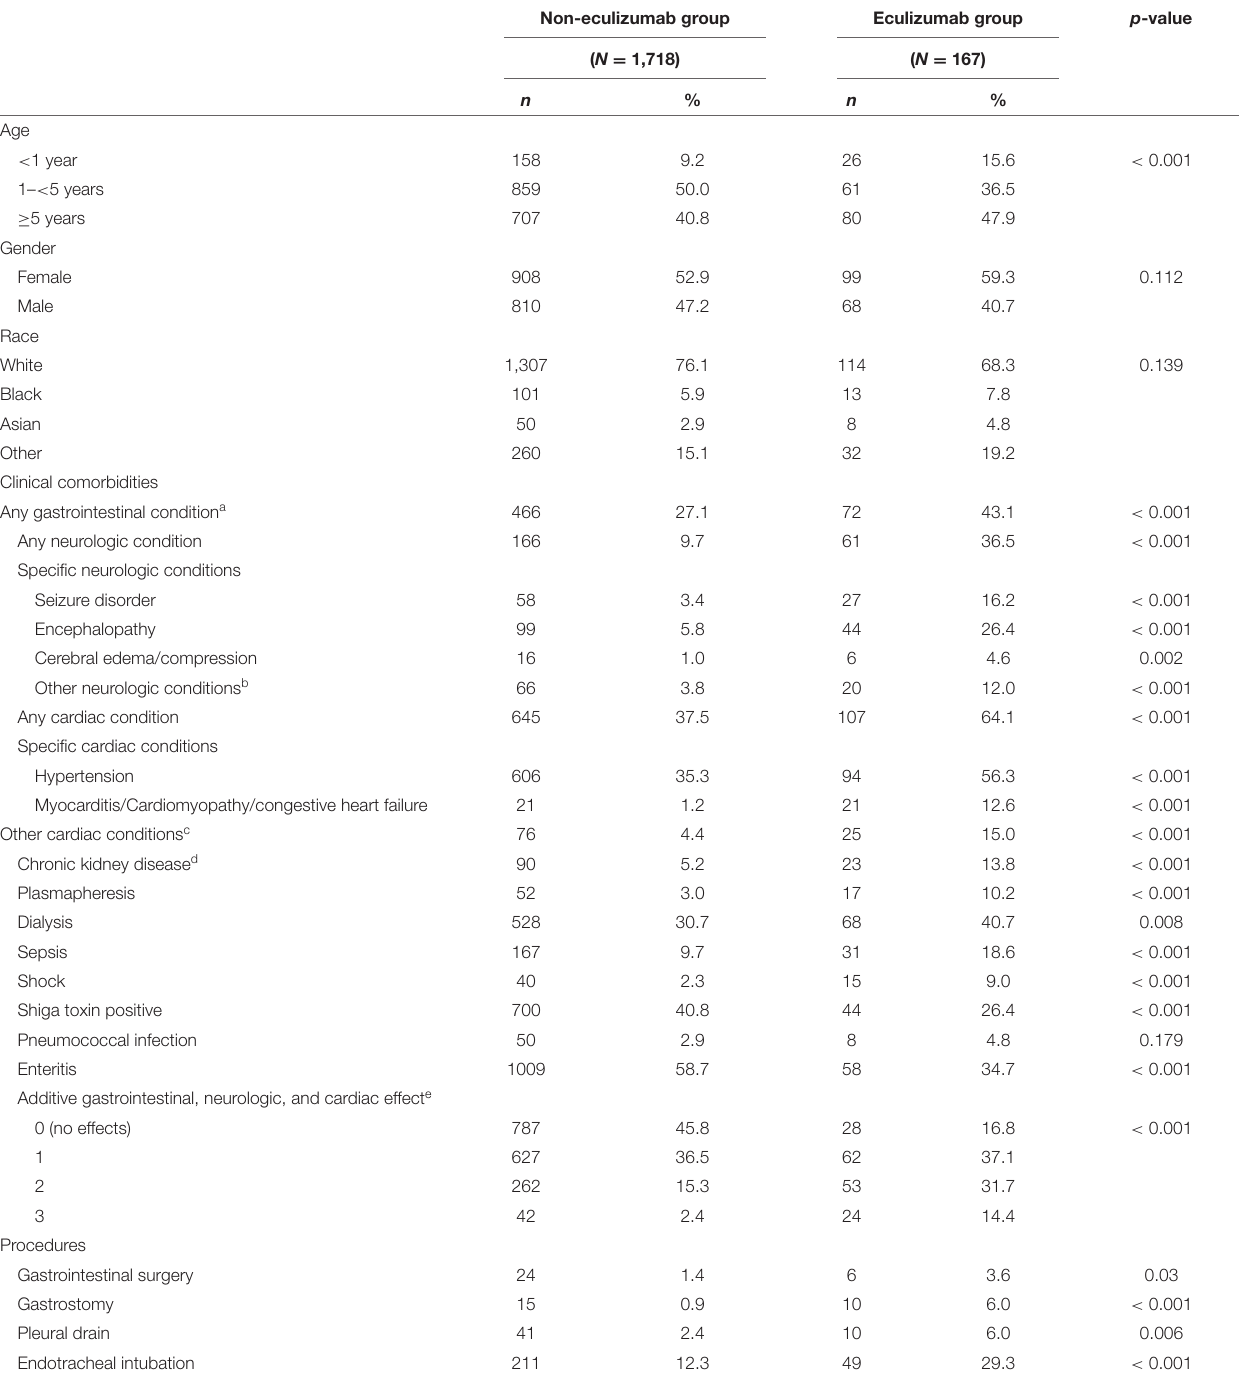
TABLE 1 | Descriptive statistics at index hospitalization for children with hemolytic uremic syndrome with and without eculizumab therapy on or after the index hospitalization.